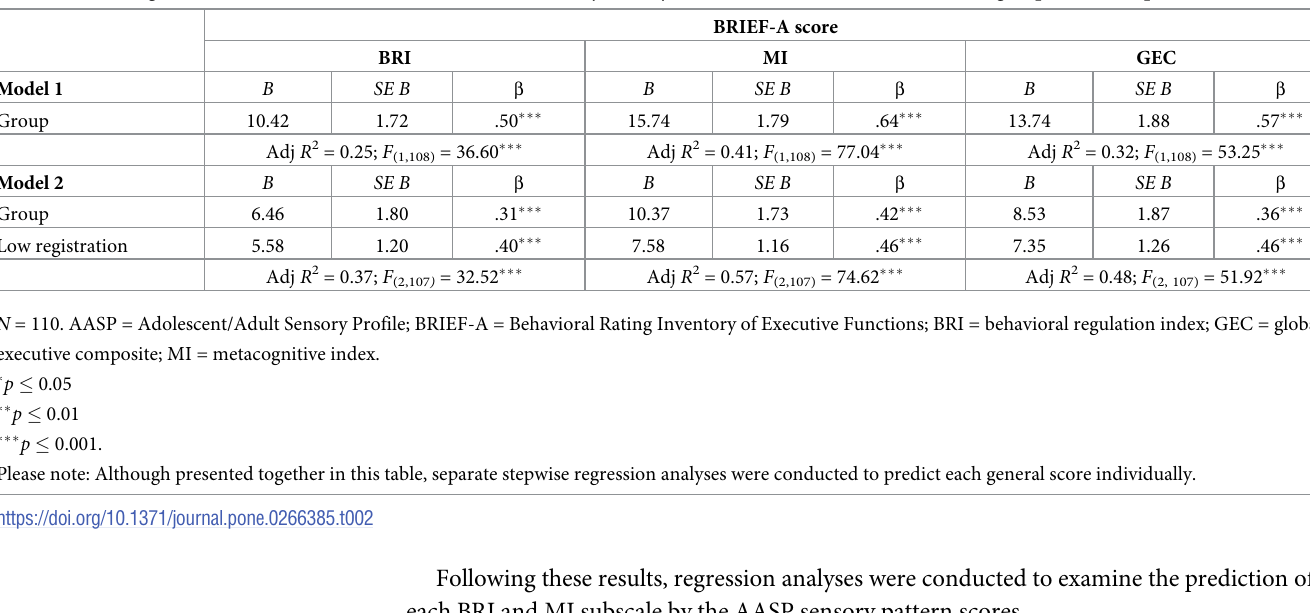
Table 2. Predicting each General Executive Function (BRIEF-A) Score by Sensory Patterns (AASP) subscale scores above group